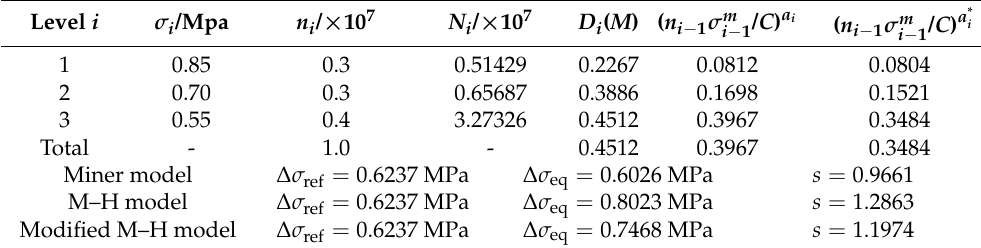
Table 2. Three-level loads are designed in the high-and-then-low loading sequence.